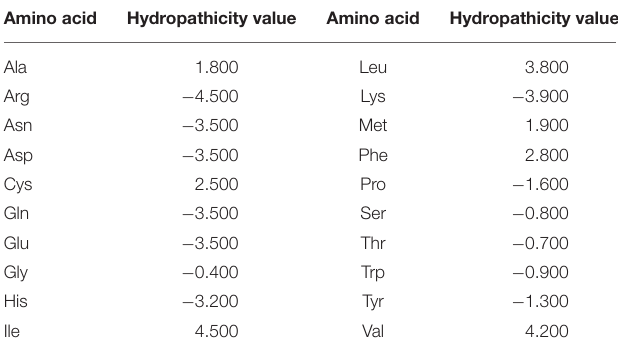
TABLE 2 | The scale of hydropathical value among amino acids. Amino